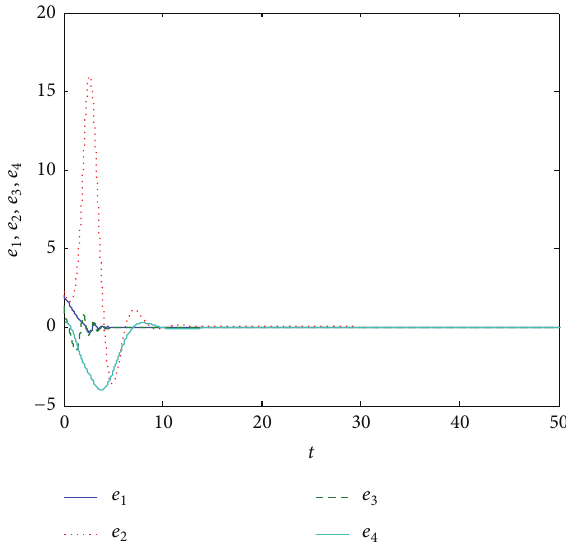
Figure 3: Time evolution of synchronization error between system (25) and system